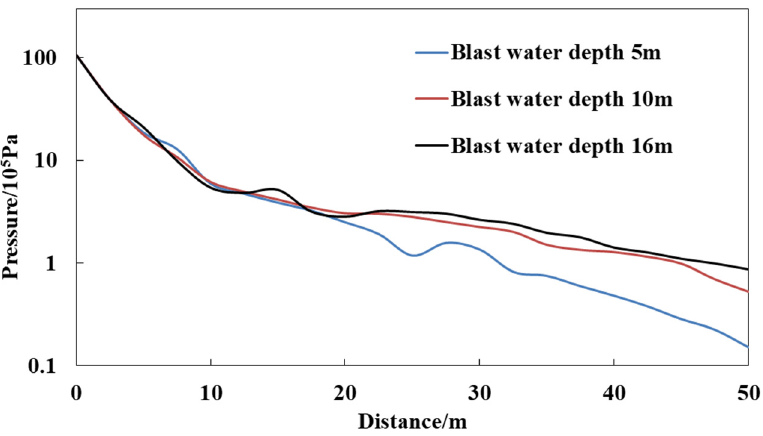
Figure 9. Transmission pattern of shock wave pressure under different water depths.